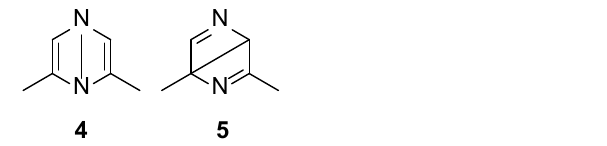
Figure 3. Dewar isomers in the photoisomerization of 2,6-dimethylpyrazine.